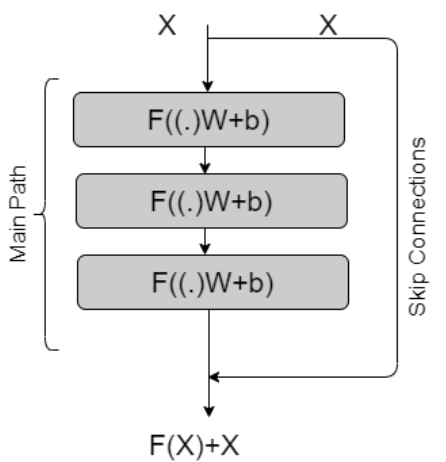
Figure 5. One Resblock in resnet50 with main and skip